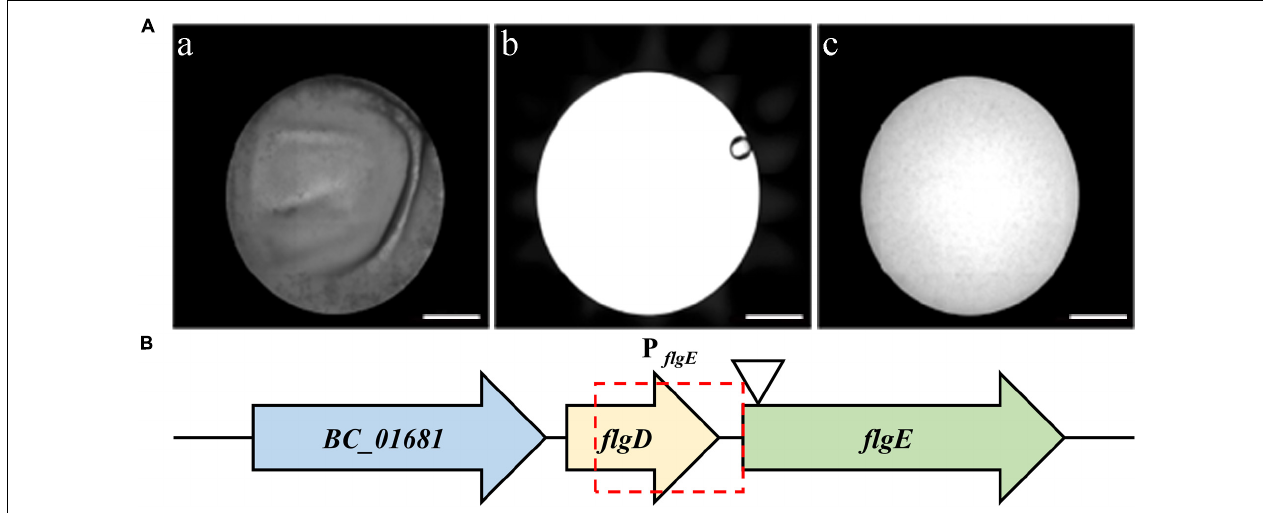
FIGURE 2 | Screening of mutants with biofilm formation defects. (A) microplate reader images of wild-type strain (a), only TSB medium (b), and the mutant 3-86 (c). Scale bar = 2 millimeters. (B) Diagram showing the transposon insertion site of the defective mutant. Potential promoter of flgE is indicated by the red frame. The position of the TnYLB-1 transposon in flgE on the chromosome of B. cereus 892-1 is indicated by the triangle.